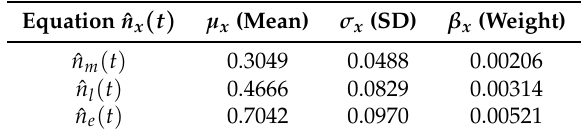
Table 1. Parameters for normal distributions.